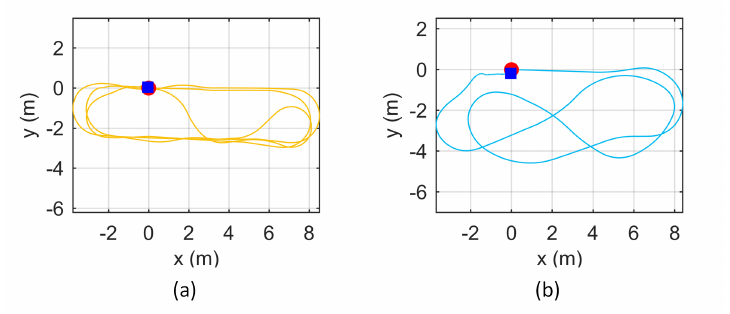
Figure 8. Robot trajectories of data ( a , b ). Red circles are starting points, and blue squares are the path ends; ideally, they should be